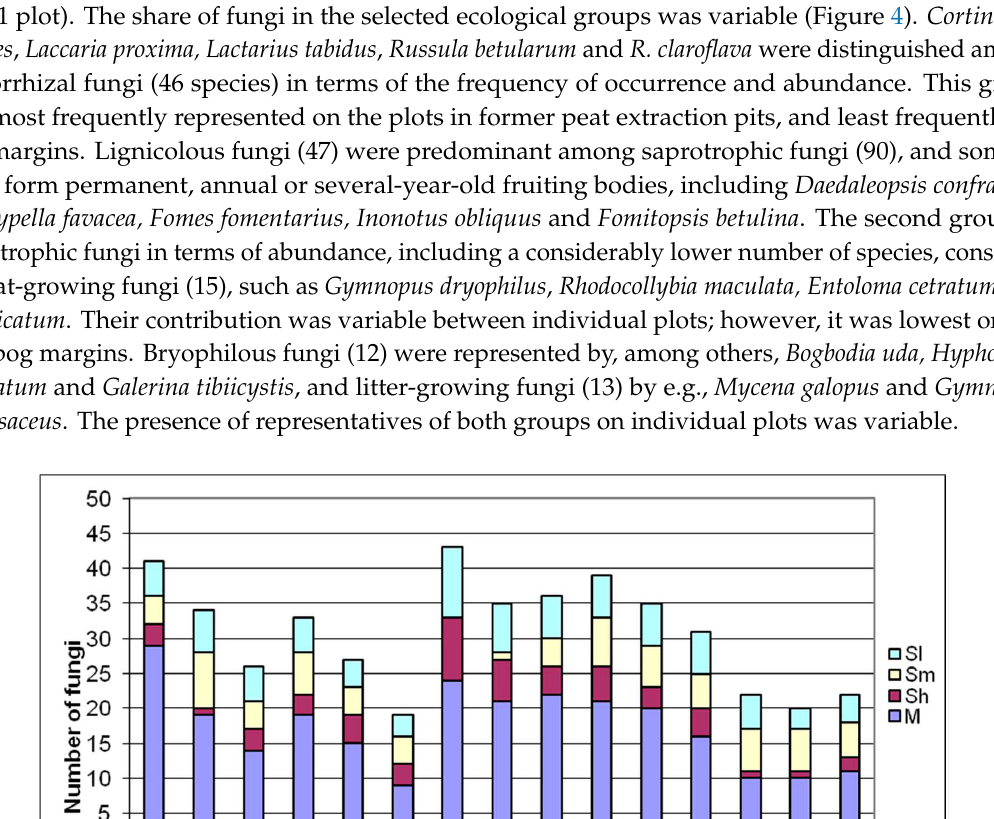
Figure 3. The vegetation cover in layers of the patches. Abbreviations: ‘a+b’—cover of tree and shrub layer, c—cover of herb layer, d—cover of moss layer.